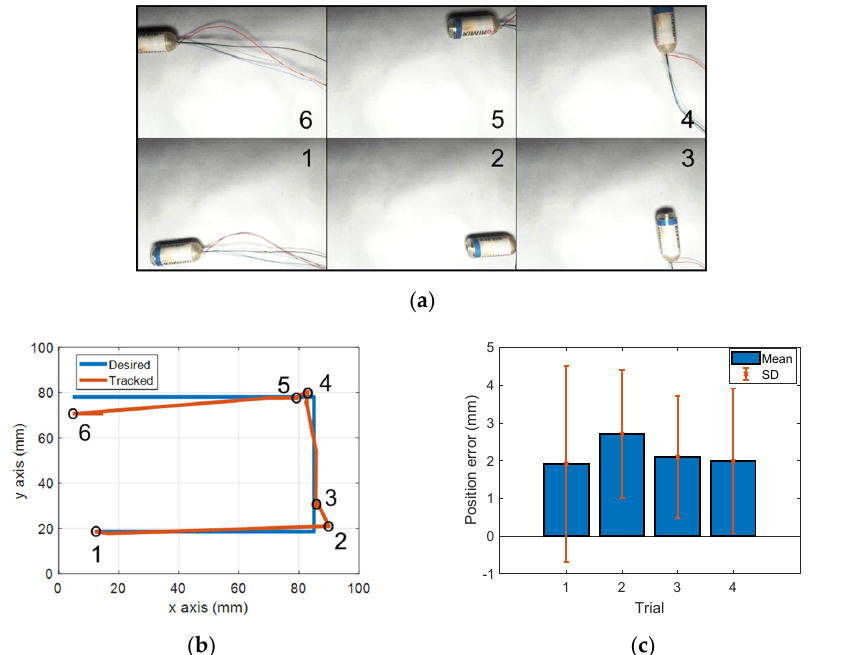
Figure 7. Demonstration of active locomotion in free space. ( a ) Snapshot of capsule robot’s position, ( b ) tracking and desired position of capsule, ( c ) statistical analysis of the movement accuracy with mean and standard deviation (SD) in four trials. The numbers 1, 2, 3, 4, 5, 6 represent the positions of capsule endoscope.